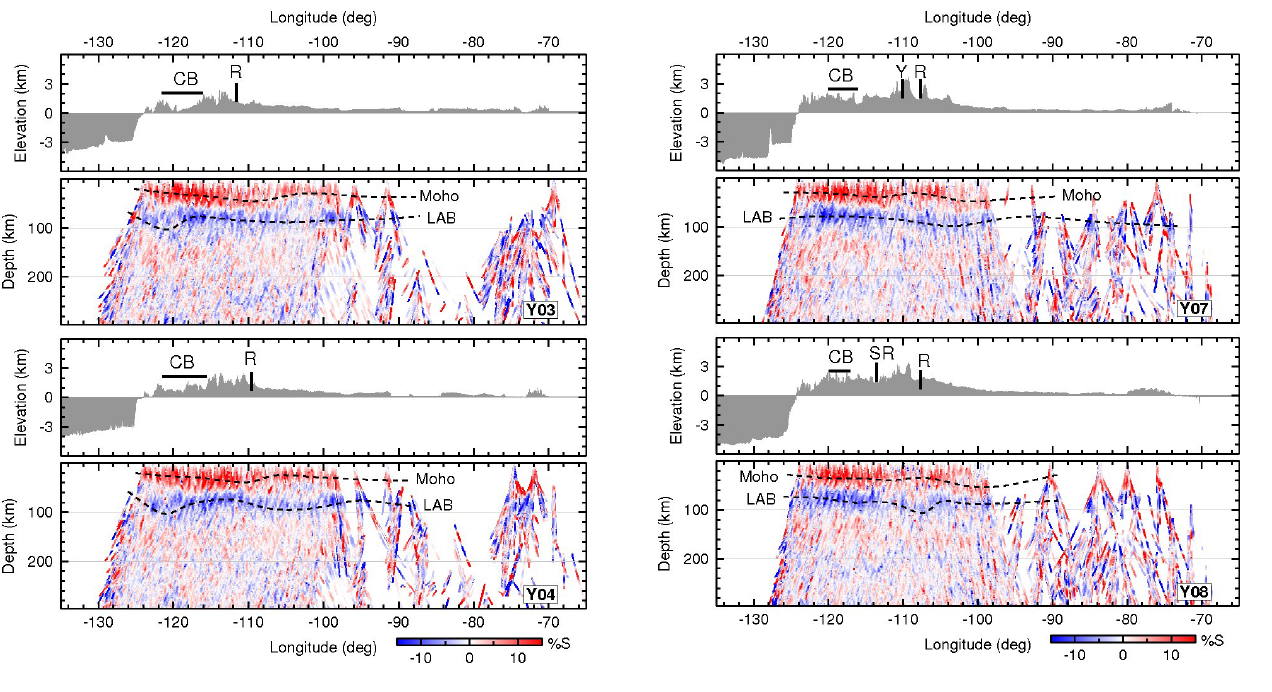
Fig. 6. Migrated S receiver functions along profiles Y07 and Y08 as Fig. 4. Migrated S receiver functions along profiles Y03 and Y04 as Figure 4 in Fig. 3. in Fig. 3. Migrated S receiver functions along profiles Y07 and Y08 as in Fig. 3. Migrated S receiver functions along profiles Y03 and Y04 as in Fig. 3.